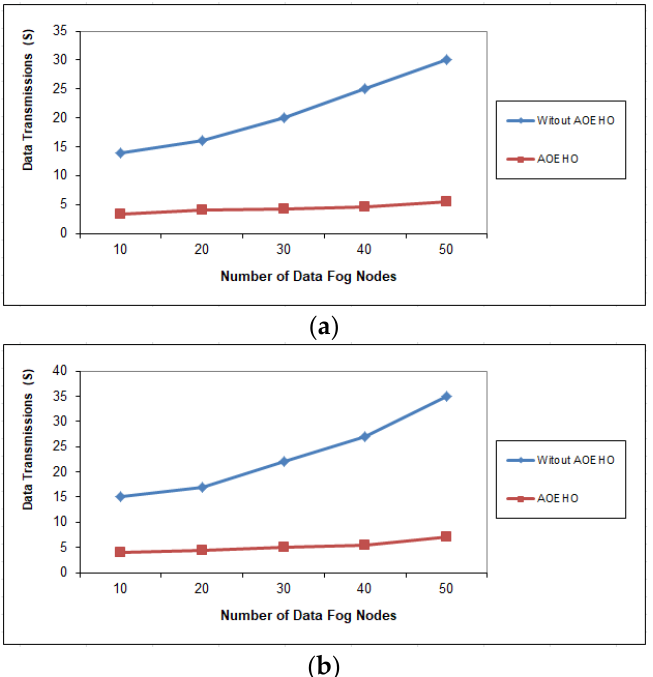
Figure 9. Data transmission between fog nodes = 50 nodes. ( a ) Size of data replication = 64 MB. ( b ) Size of data replication = 320 MB.